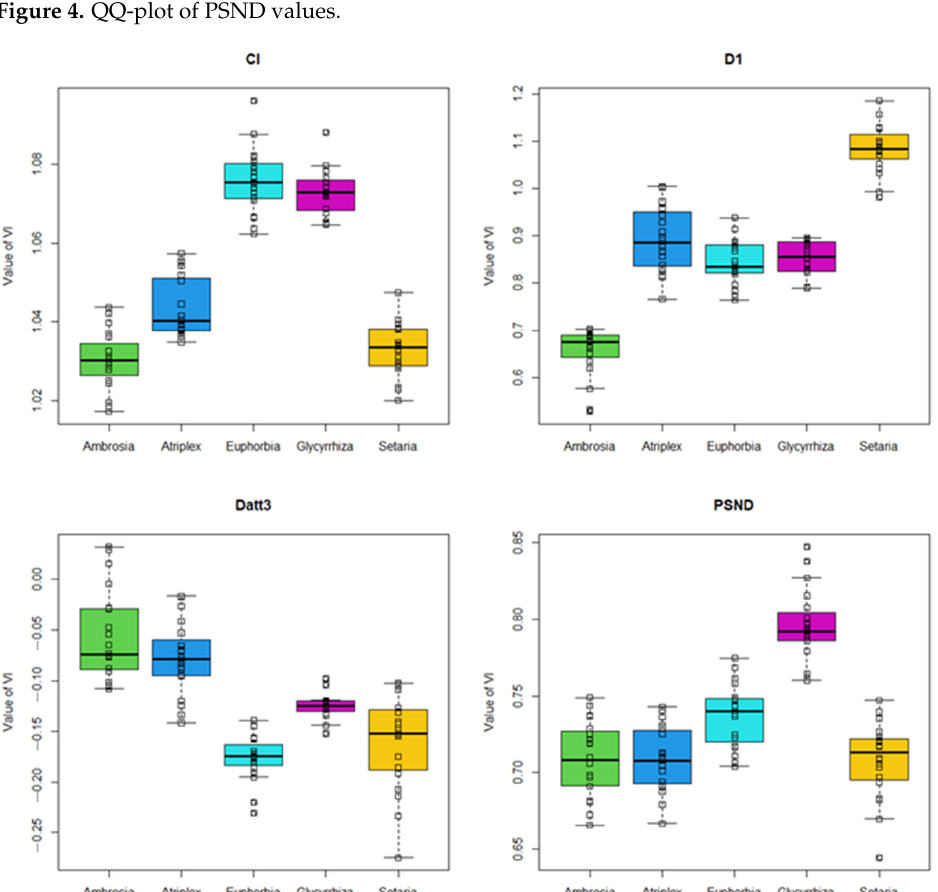
Figure 5. Boxplot of significantly different Vis for Ambrosia artemisiifolia , Atriplex tatarica , Glycyrrhiza glabra , Euphorbia seguieriana , and Setaria pumila .